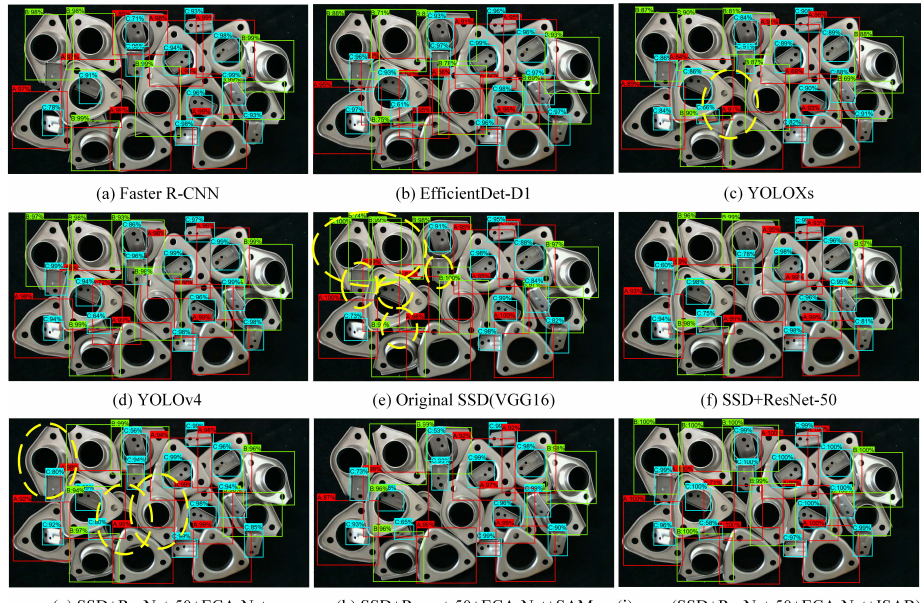
Figure 10. The actual results of six algorithms for metal parts recognition are shown. (The yellow ellipse dotted line in the figure is the model’s misidentified or missed